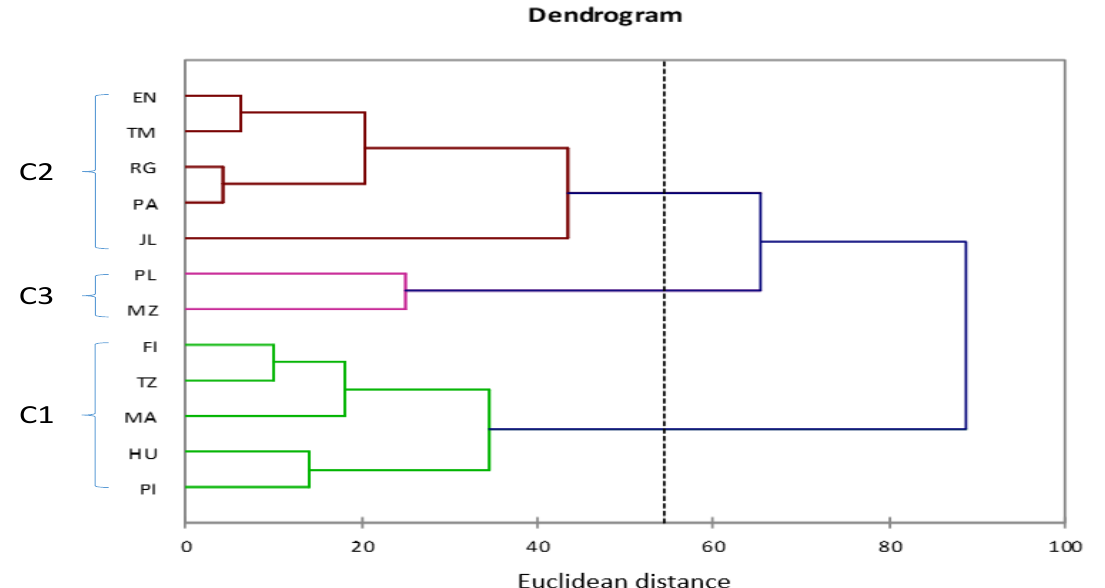
Figure 2. Dendrogram of dissimilarity of Euclidean distances between study sites based on average physicochemical values of all study periods.